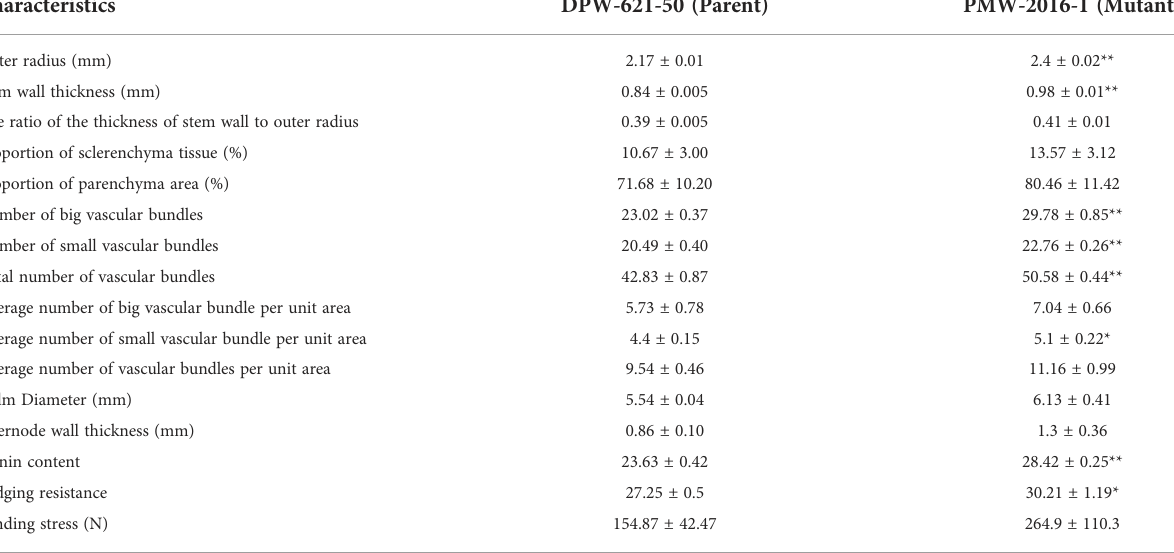
TABLE 2 Comparison of anatomical features and compositions of 2 nd Internode among DPW-621-50 (parent) and PMW-2016-1 (lodging tolerant mutant). Characteristics